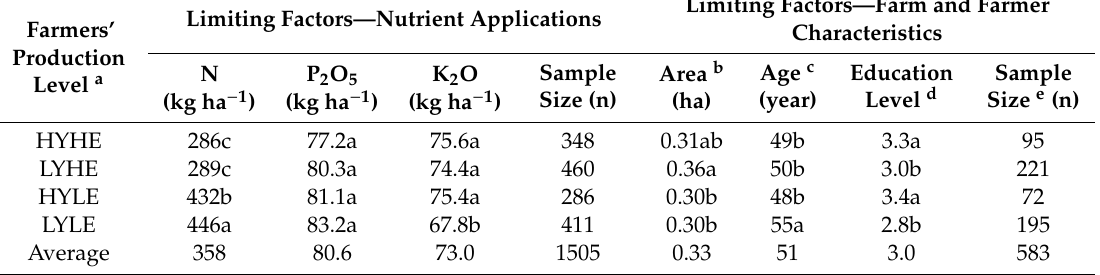
table is for each family. c and d Age and education level of the main labor force engaged in agriculture in each family are presented. The classification standard of farmers’ education level is based on the following method: Level 1, uneducated with 0 years of education; Level 2, primary school incomplete with 1 − 6 years of education; Level 3, primary school completed with 6 years of education; Level 4, middle school with 6 − 9 years of education; Level 5, high school with 9 − 12 years of education; Level 6, higher education with more than 12 years of education. e It was challenging to collect data on education level, age of the major workforce and planting area given